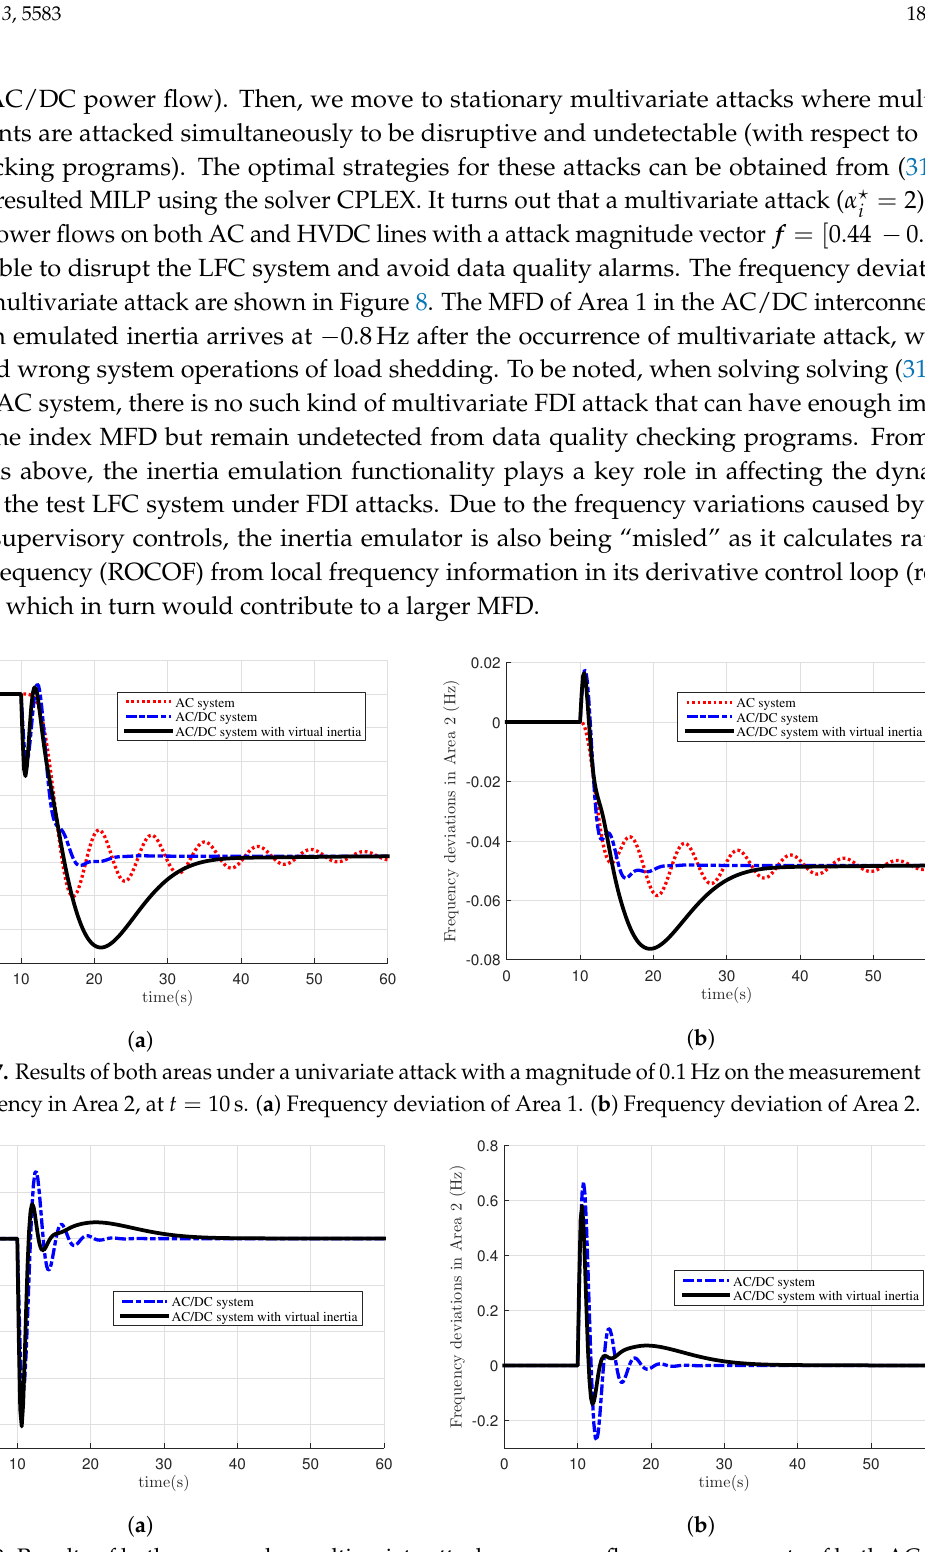
Figure 8. Results of both areas under multivariate attacks on power flow measurements of both AC and HVDC lines with magnitudes of 0.44p.u. and − 0.39p.u., respectively, at t = 10s. ( a ) Frequency deviation of Area 1. ( b ) Frequency deviation of Area